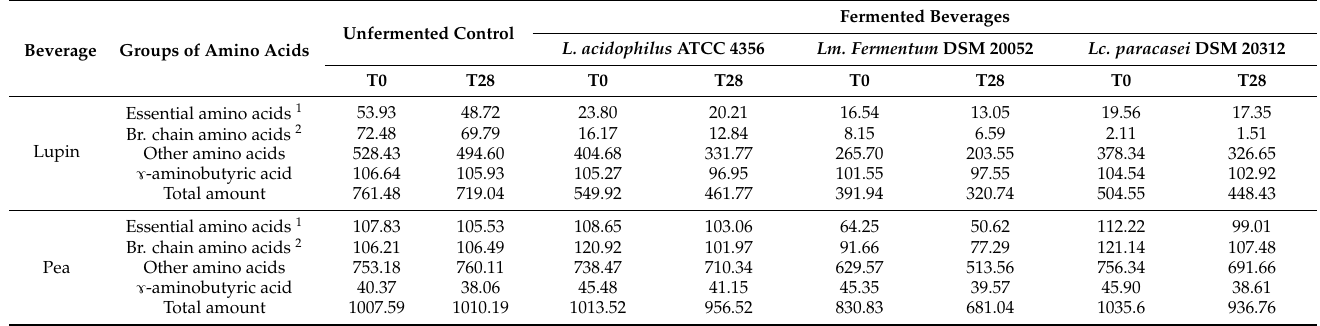
Table 9. Concentrations of free amino acids (expressed in mg L − 1 ) in fermented beverages and in unfermented water extracts at the beginning (T0) and at the end (T28) of refrigerated (4 ◦ C) storage